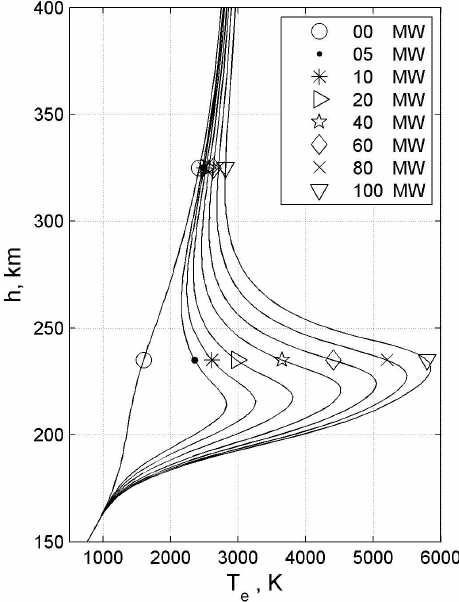
Fig. 5. Profiles of the electron temperature (in absolute degrees) versus distance from the Earth along the geomagnetic field line sit- uated in the illuminated region at the moment of 300s after turn on. The results are given for the incident wave frequency value of 7.85MHz and different values of the EAP: 5, 10, 20, 40, 60, 80, and 100MW, with symbol 0MW indicating the results obtained under natural conditions without heating.